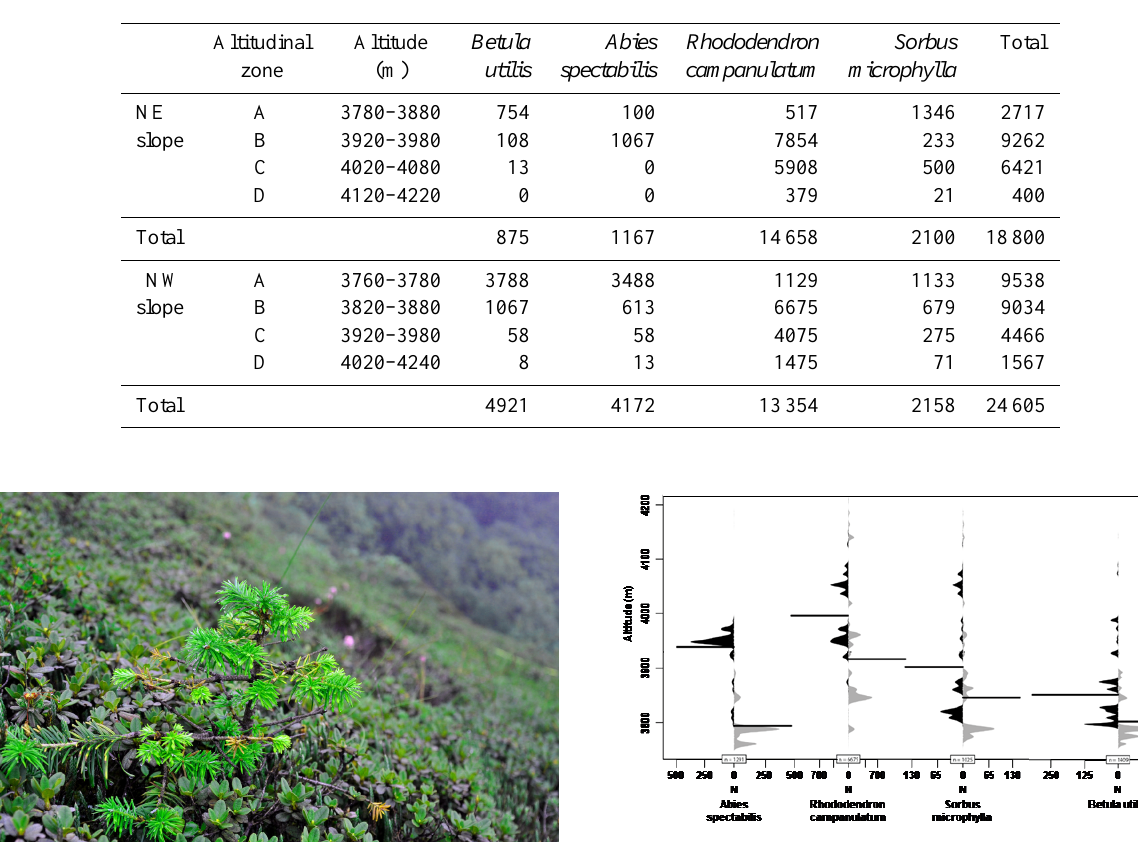
Table 1. Number of seedlings/saplings ( < 7cm breast height diameter; Nha − 1 ) of Betula utilis , Abies spectabilis , Rhododendron campanu- latum , and Sorbus microphylla in the treeline ecotone in Rolwaling Valley according to slope exposure and altitudinal zone.